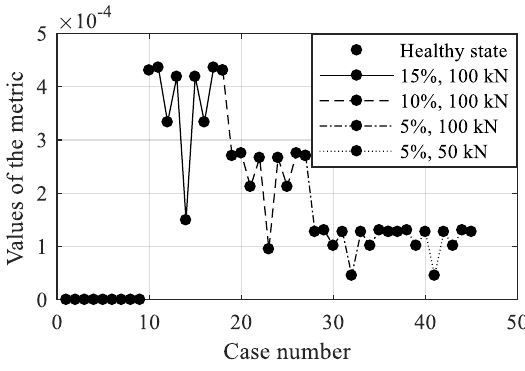
Figure 4. Comparison of the metric values of the different cases.